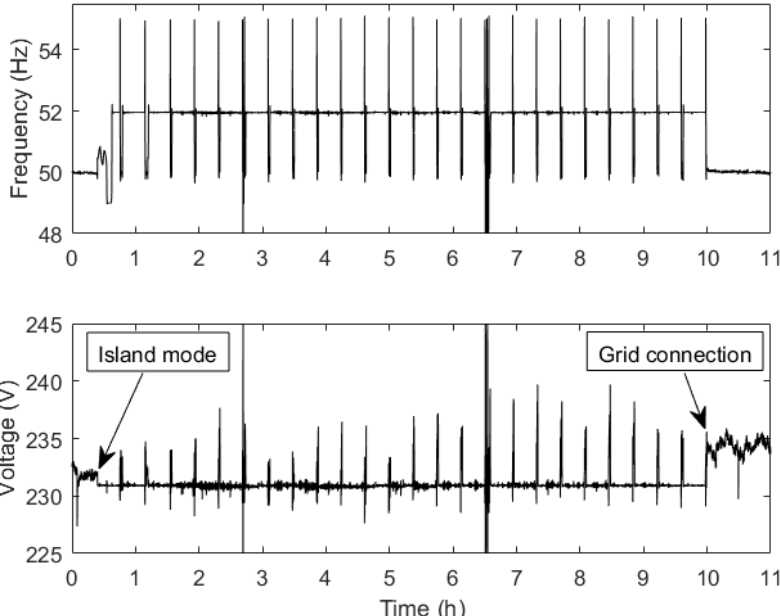
Figure 5. The one cycle average frequency between 08:00 and 19:00 the 25th September 2016 when there is not enough loads to consume the entire production from the PV installation ( top ) with the corresponding one cycle average phase-to-neutral voltage for one phase ( bottom ). The frequency scale is truncated at 48 Hz since there are two interruptions in the plot that make the frequency drop to zero. The voltage scale is truncated at 245 V and 225 V to give a better representation of the voltage variations.